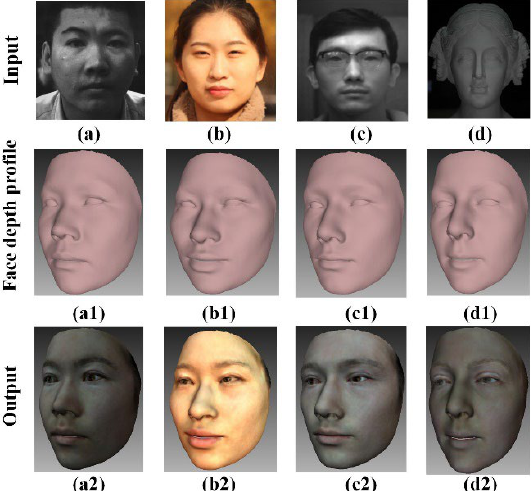
Figure 5. Reconstructed 3D faces using CNN-based 3DMM; ( a ) a photo of a Chinese man; ( b ) a Chinese woman wearing no glasses; ( c ) a Chinese man wearing near-infrared glasses; ( d ) a plaster statue; ( a1 – d1 ) reconstructed face depth profile of ( a – d ); ( a2 – d2 ) finally, reconstructed 3D face of ( a – d ).